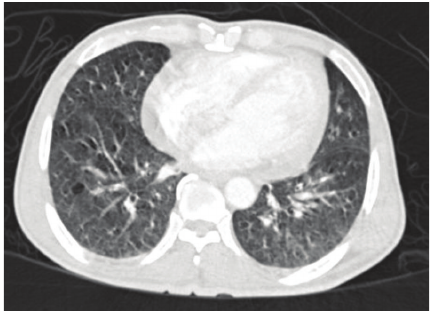
Figure 4: Computed tomography of chest: multiple nodular opac- ities in the upper lobe of right lung with interlobular interstitial thickening. Minimal pericardial effusion.